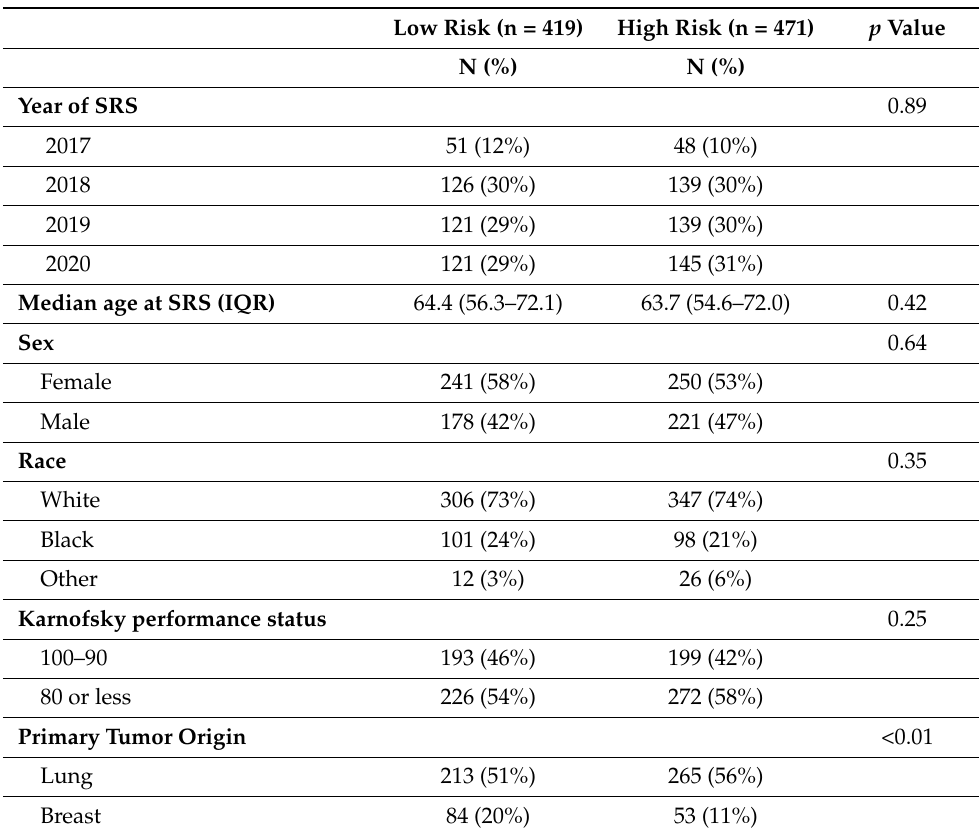
(19% high-risk, 34% low-risk, p < 0.01), and pre-SRS chemotherapy receipt (45% high-risk, 57% low-risk, p < 0.01). Table 4. Demographic, clinical, and treatment parameters across all patients by intracranial pro- gression nomogram strata. Abbreviations: Interquartile range, IQR; stereotactic radiosurgery, SRS; planned target volume, PTV.